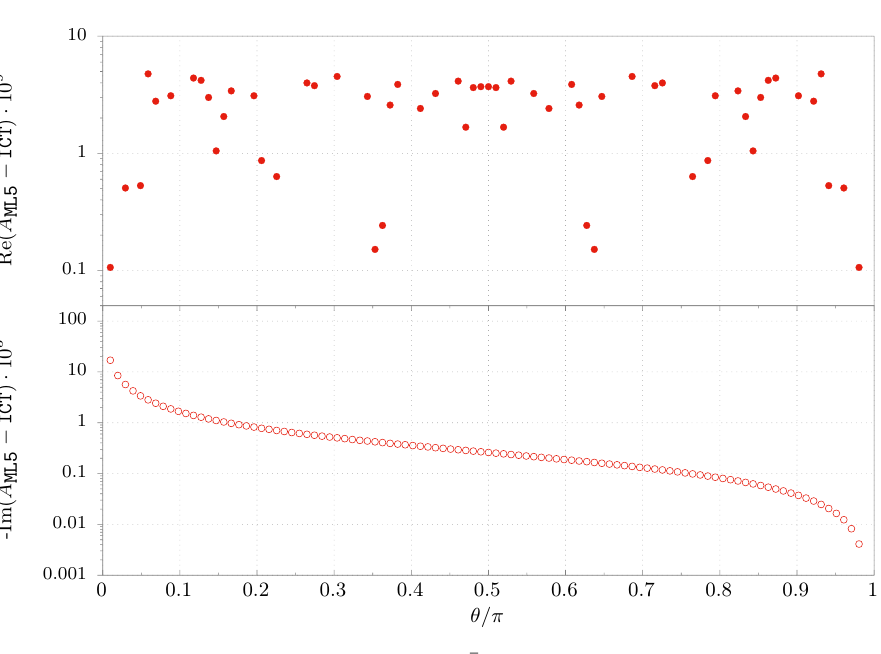
Figure 22. A scan of our results using numerical LTD for the d (cid:22) d scattering angle (cid:18) 13 . In (cid:12)gure (a-b) we can see the results computed with LTD compared with the analytic expression obtained with MadLoop5 [105, 106] ( ML5 ). In the last plot we show the result of the integral of the the (cid:12)nite regulated integrand that we actually integrate numerically. This corresponds to subtracting the integrated counterterms to the exact analytic result for the amplitude.